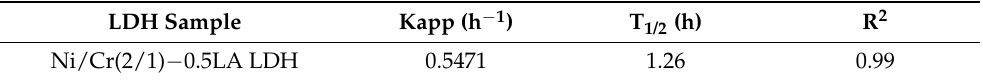
Table 3. Pseudo-first-order kinetics parameters for MO photodegradation by Ni/Cr(2/1) − 0.5LA LDH. LDH Sample